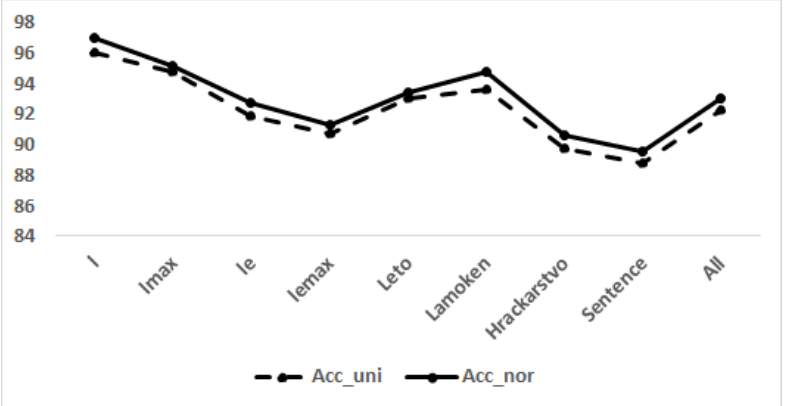
Figure 6. Comparison results of accuracy for various tasks in terms of uniform and normal distributions.